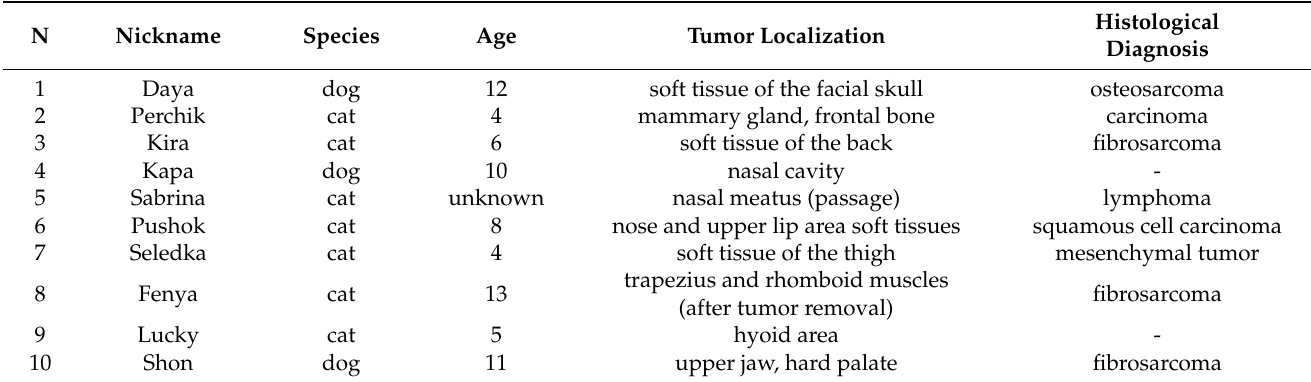
Table 1. Data on gender, species, age, localization and type of tumors in animals participating in the study.